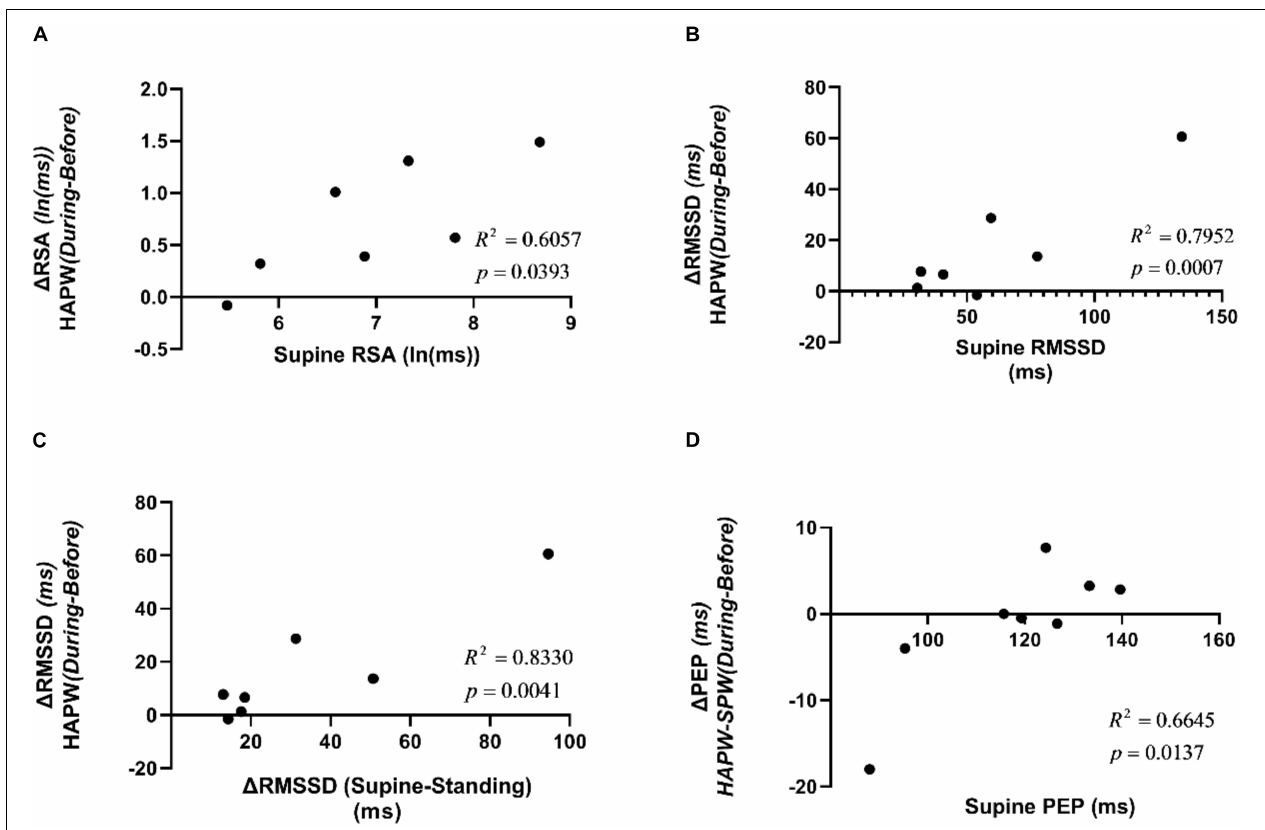
FIGURE 12 | Correlations between supine HRV parameters and changes in HRV parameters due to posture changes compared to the changes in those measures due to motor activity. (A) Correlation between RSA during supine rest and change in RSA during HAPW. (B) Correlation between RMSSD during supine rest and change in RSA during HAPW. (C) Correlation between change in RMSSD from supine to standing and change in RSA during HAPW. (D) Correlation between PEP during supine rest and change in PEP during